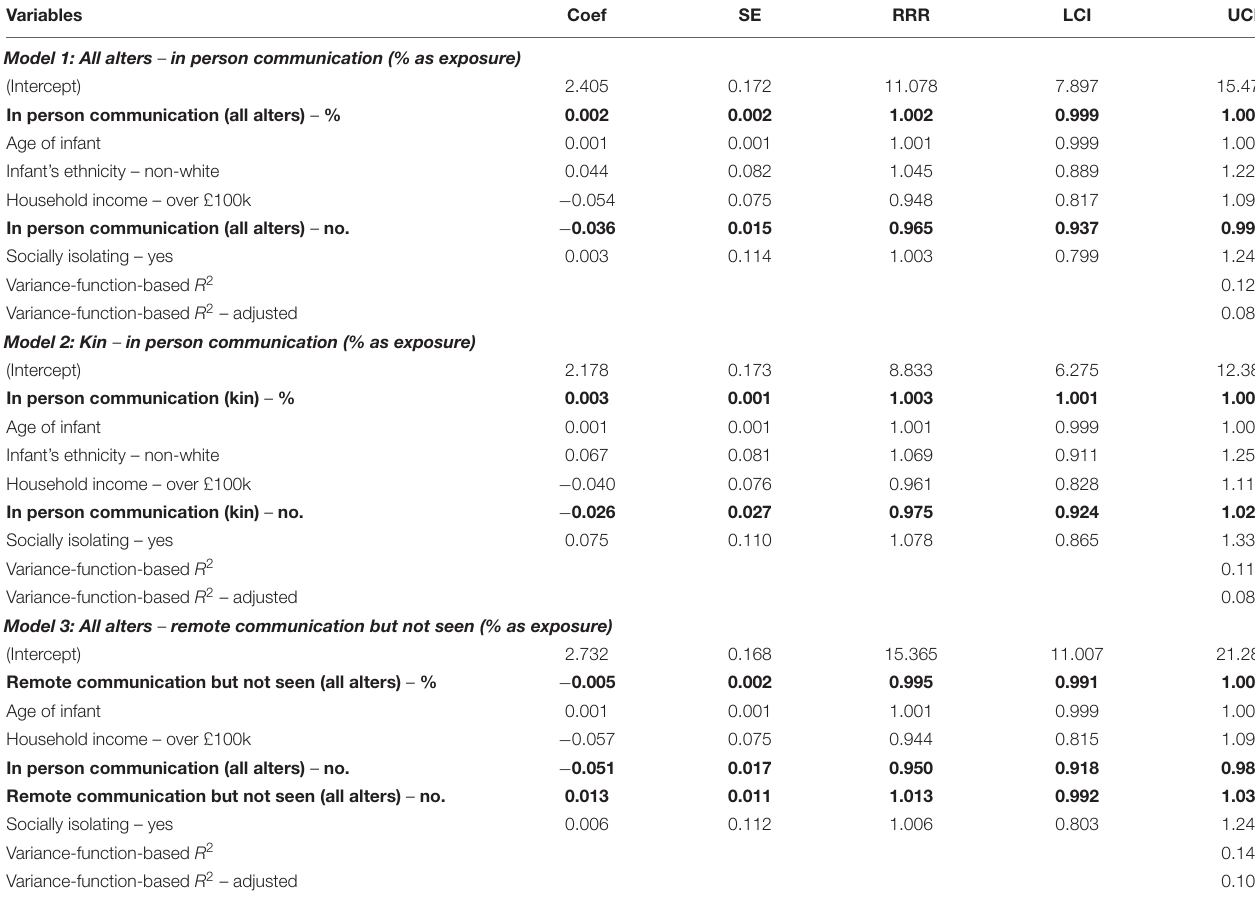
TABLE 2 | Results of quasi-Poisson regression models predicting depression symptoms as assessed via the Edinburgh Postnatal Depression Scale (EPDS) ( n = 153). Variables Coef SE RRR